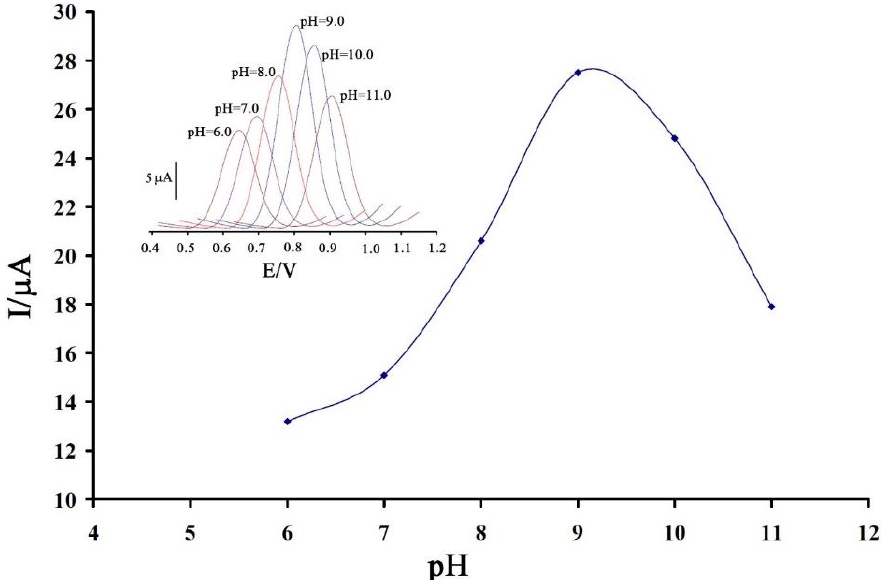
Figure 2. Plot of peak current (I pa ) vs. changing in pH value for the electro-oxidation of 100 μΜ vitamin B 9 at a surface of 1,3-DIBr/ZnO/CNTs/CPE. Inset: influence of pH on square wave voltammograms of vitamin B 9 at the surface of the modified